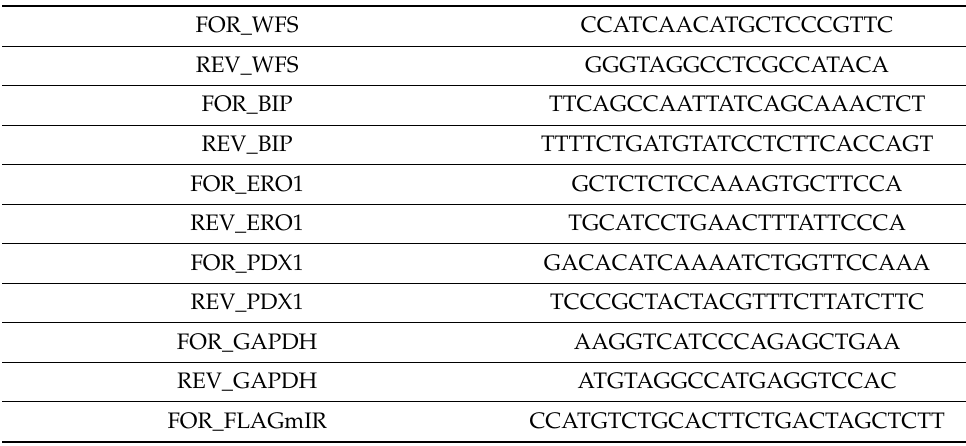
Table 2. Murine primers (5 (cid:48) –3 (cid:48) ) used for qRT-PCR